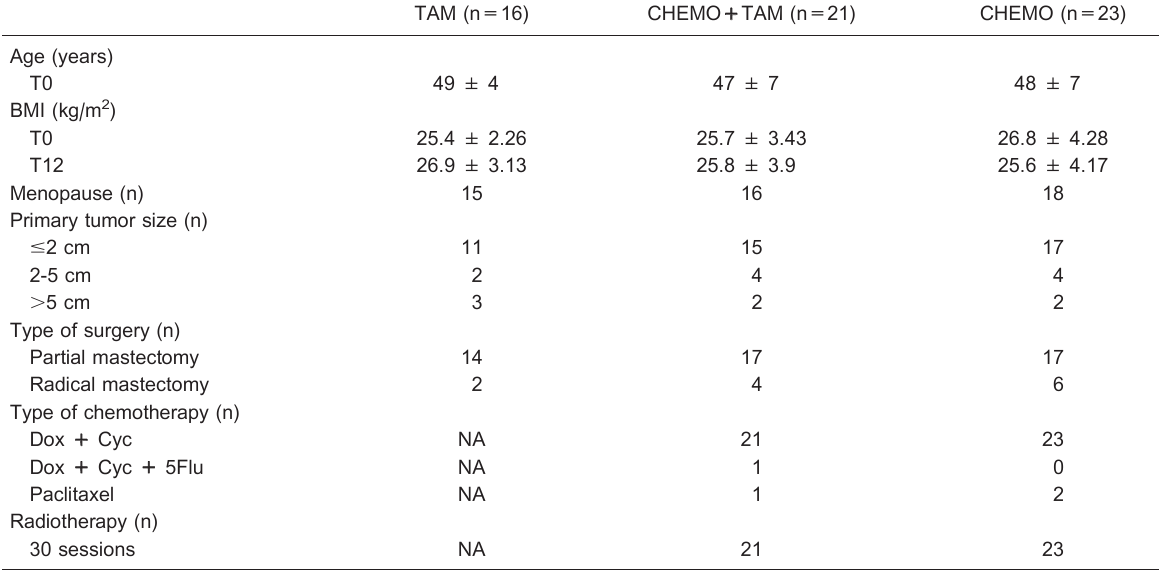
Table 1. Participants and treatment